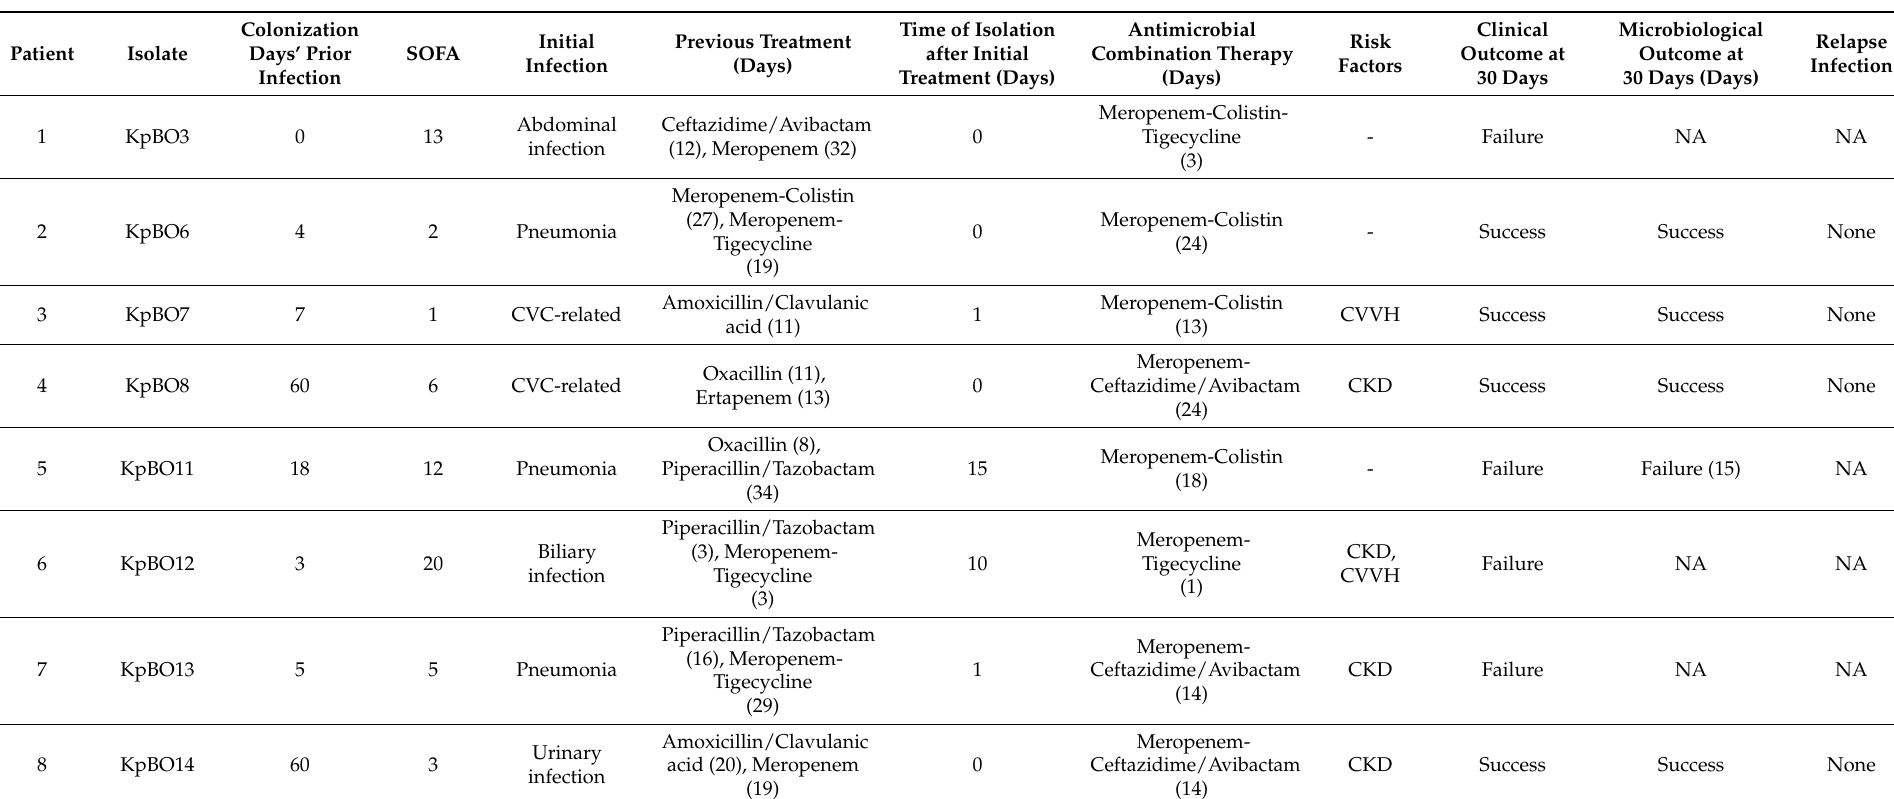
Clinical Microbiological Risk Outcome at Outcome Factors 30 Days